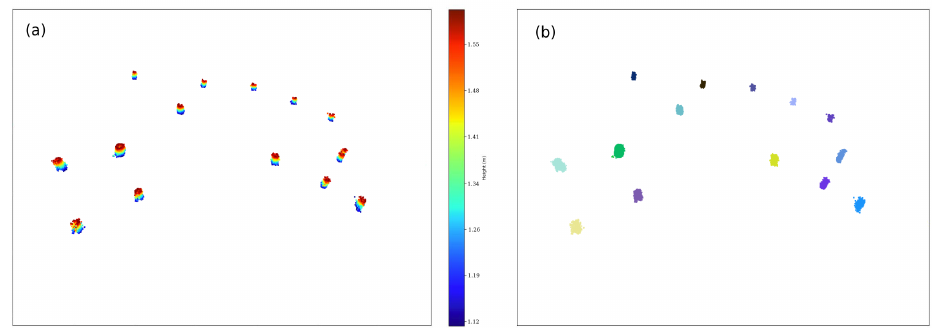
Figure 7. ( a ) Trunk layer subtraction. ( b ) Individual trunk identification via